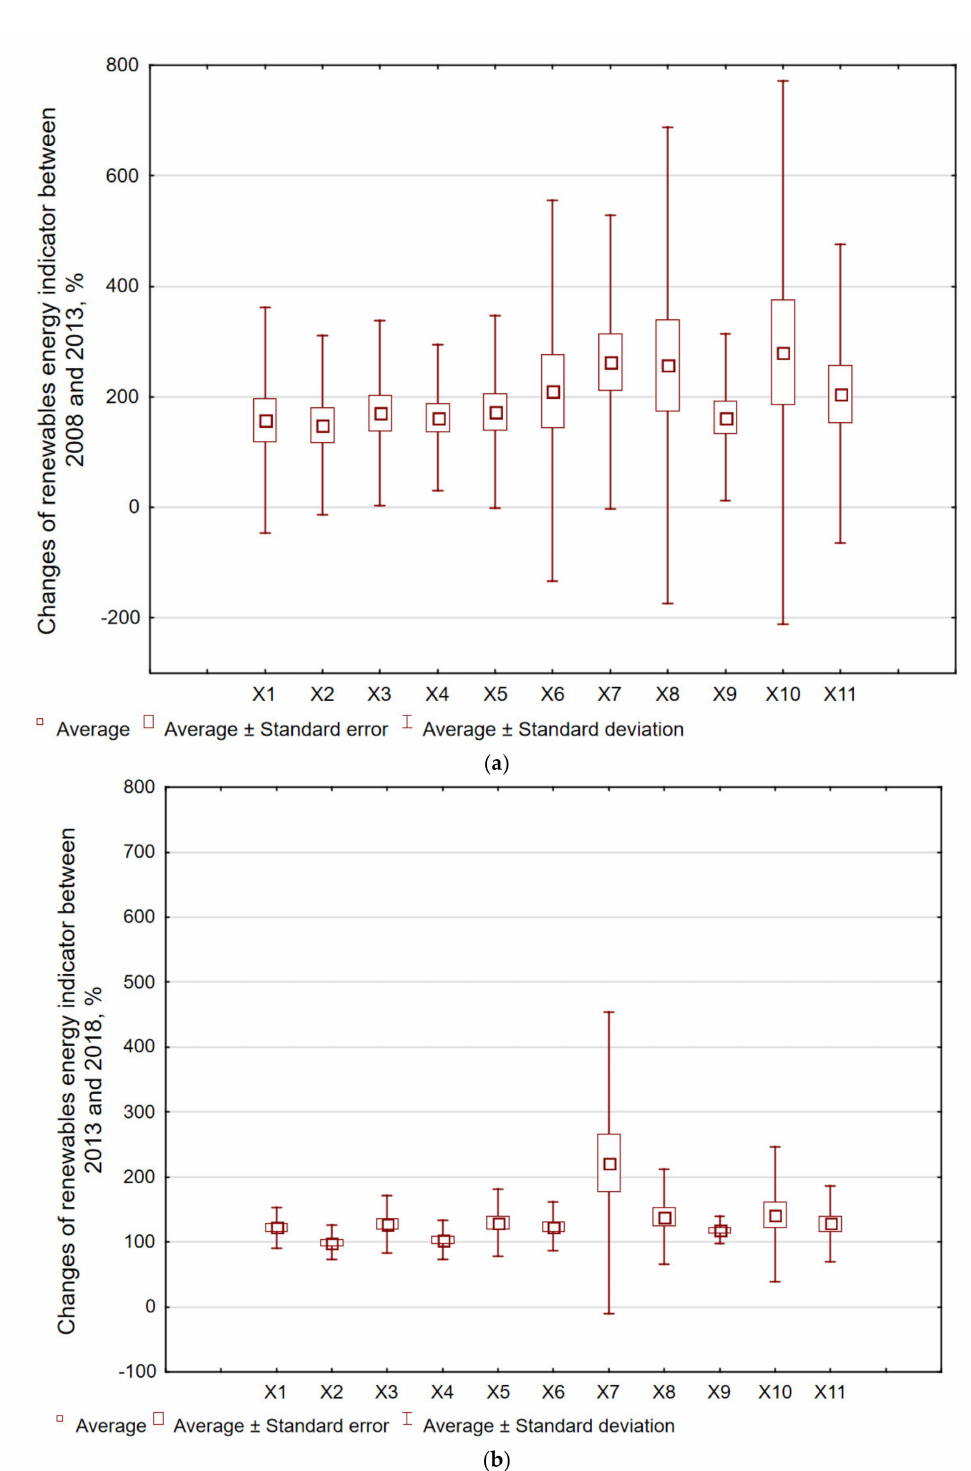
Figure 3. Percentage changes in the average values of renewable energy indicators for studied countries between 2008–2013 ( a ) and 2013–2018 ( b